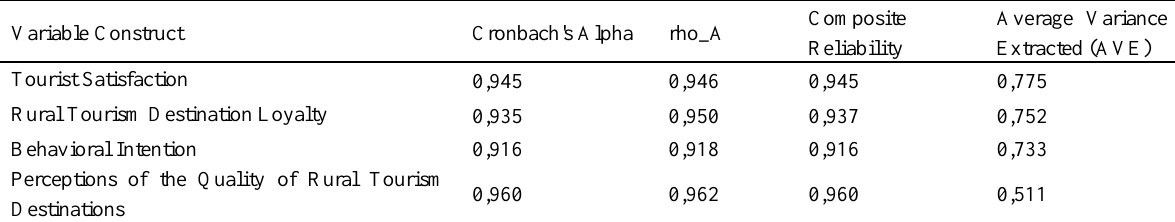
Table 2: Construct Reliability and Validity